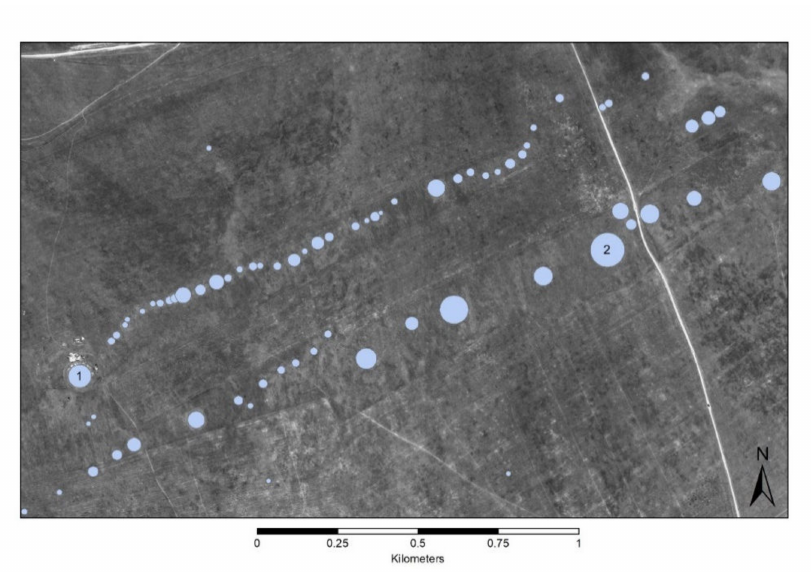
Figure 6. Several longer lines of burial mounds (all shown mounds > 15 m) with the Chinge-tei 1 burial mound currently under excavation (1) and another “royal” tomb, over 100 m in diameter, which was heavily disturbed